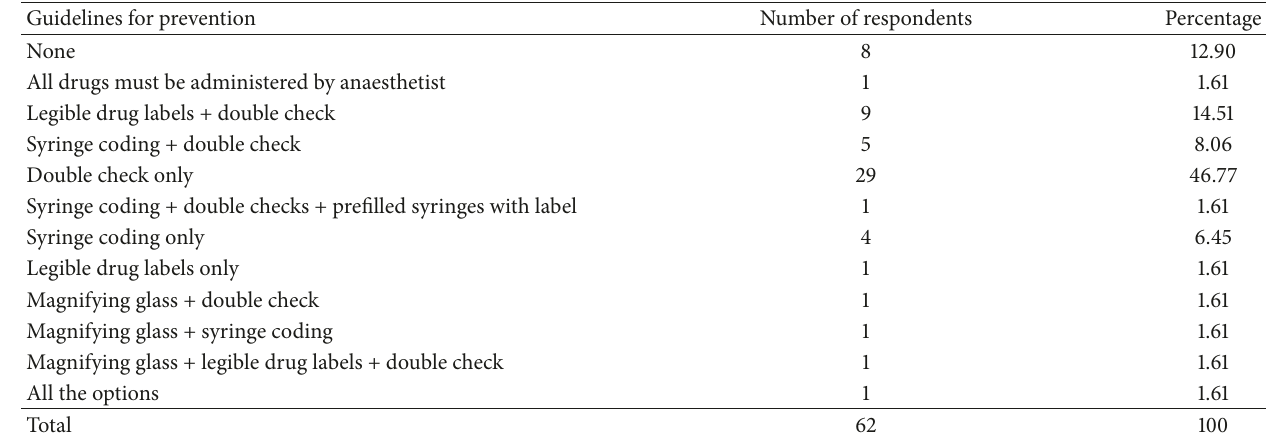
Table 3: Preventive measures in respondents’ health